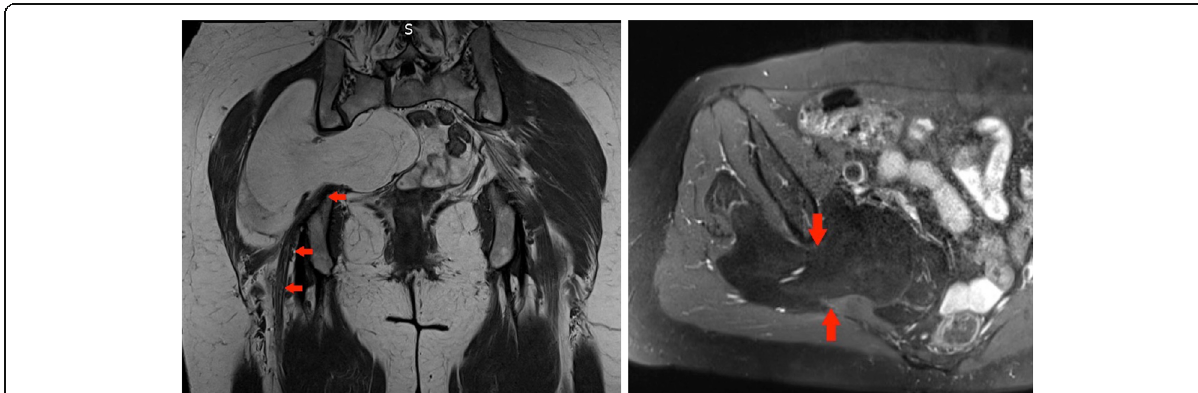
Fig. 12 Left panel: Coronal T1-weighted MR image of the pelvis shows displacement and kinking of the right sciatic nerve at the level of the posterior acetabulum (red arrows). Right panel: Axial proton density fat sat weighted image of the pelvis confirms the lesion is predominantly fat containing as it supresses on fat saturated sequences. High signal septations which do not supress can also be visualised. Red arrows outline the